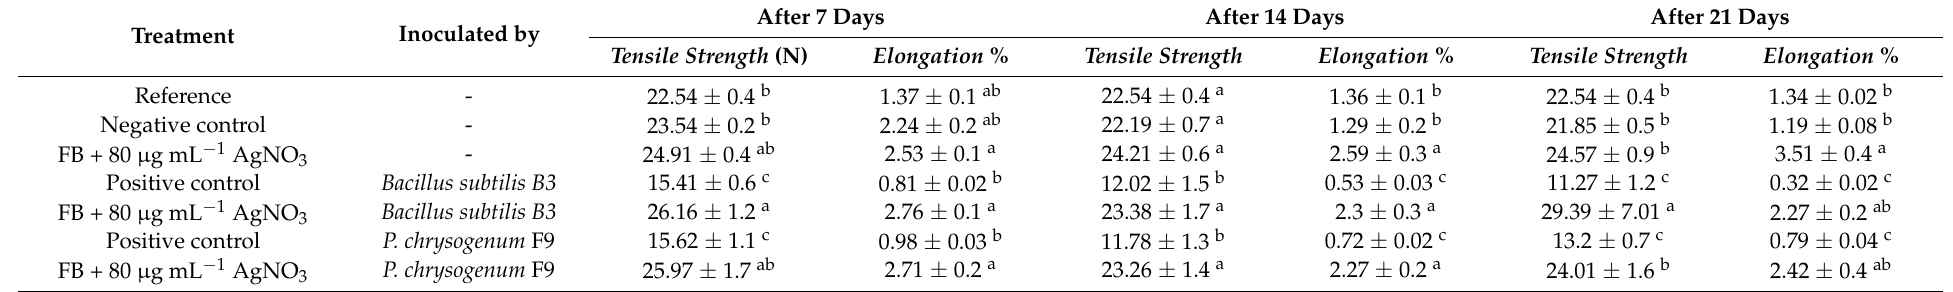
Table 3. Tensile strength (N/15 mm) and elongation (%) measurement of filter paper with/without 80 µ g mL − 1 AgNO 3 in the presence/absence of microbial inoculations.